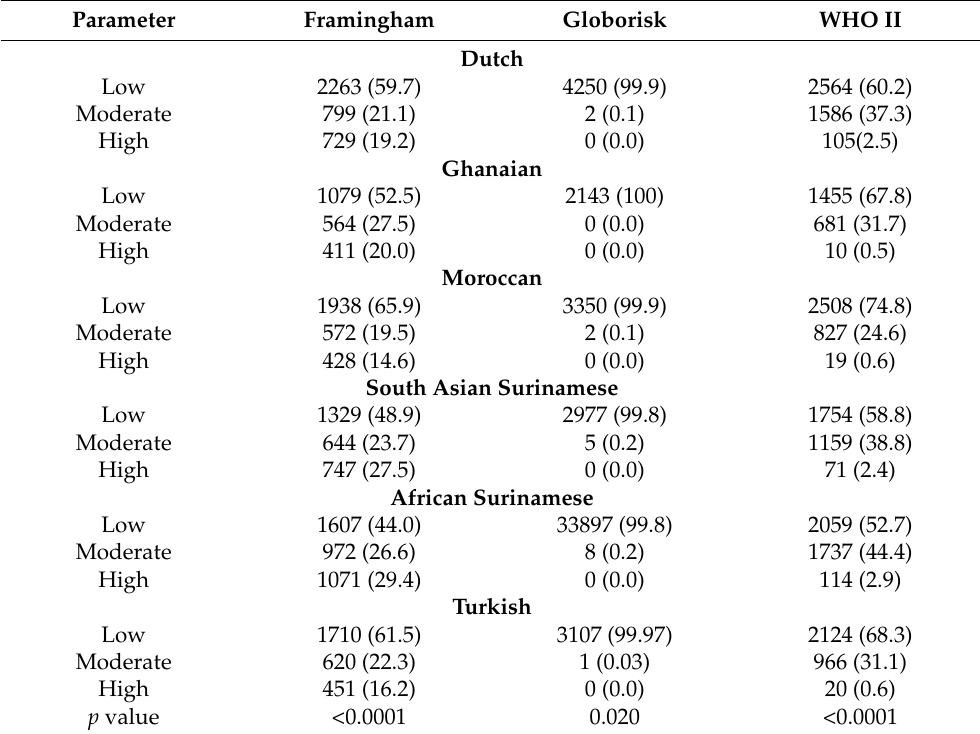
Table 5. CVD risk classification among ethnic groups living in the Netherlands using nonlaboratory- based Cardiovascular risk scores.